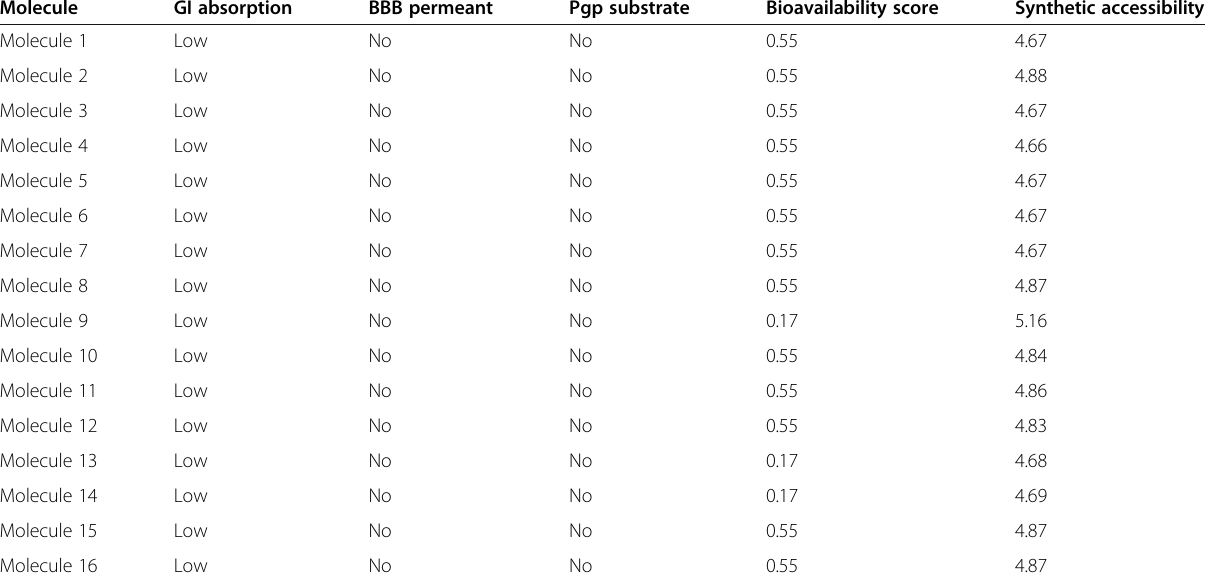
Table 7 ADME properties of the newly designed compounds Molecule GI absorption BBB